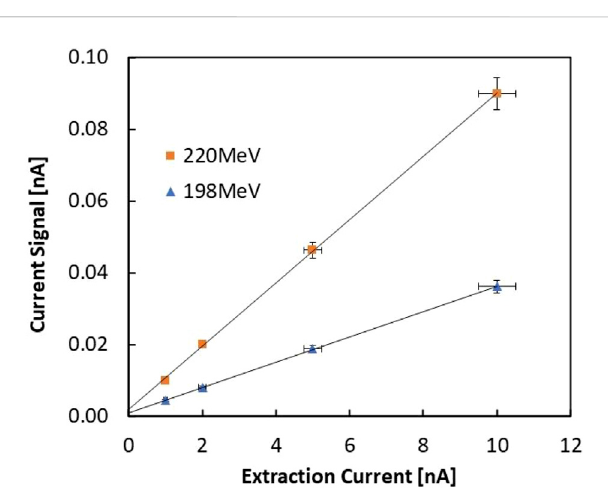
FIGURE 7 Average signals measured by the #7 (1 μ m-thick CsPbCl 3 on IDE/ Pd) prototype as a function of the extraction current respectively under exposure ofthree differentproton beam energies, applied voltage =2